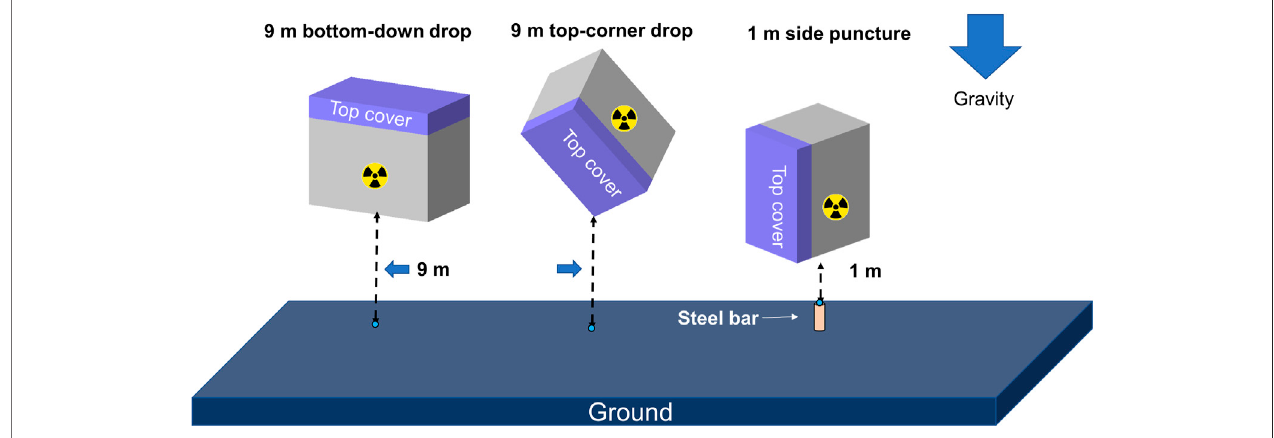
FIGURE 3 | Illustrations of the three drop scenarios.